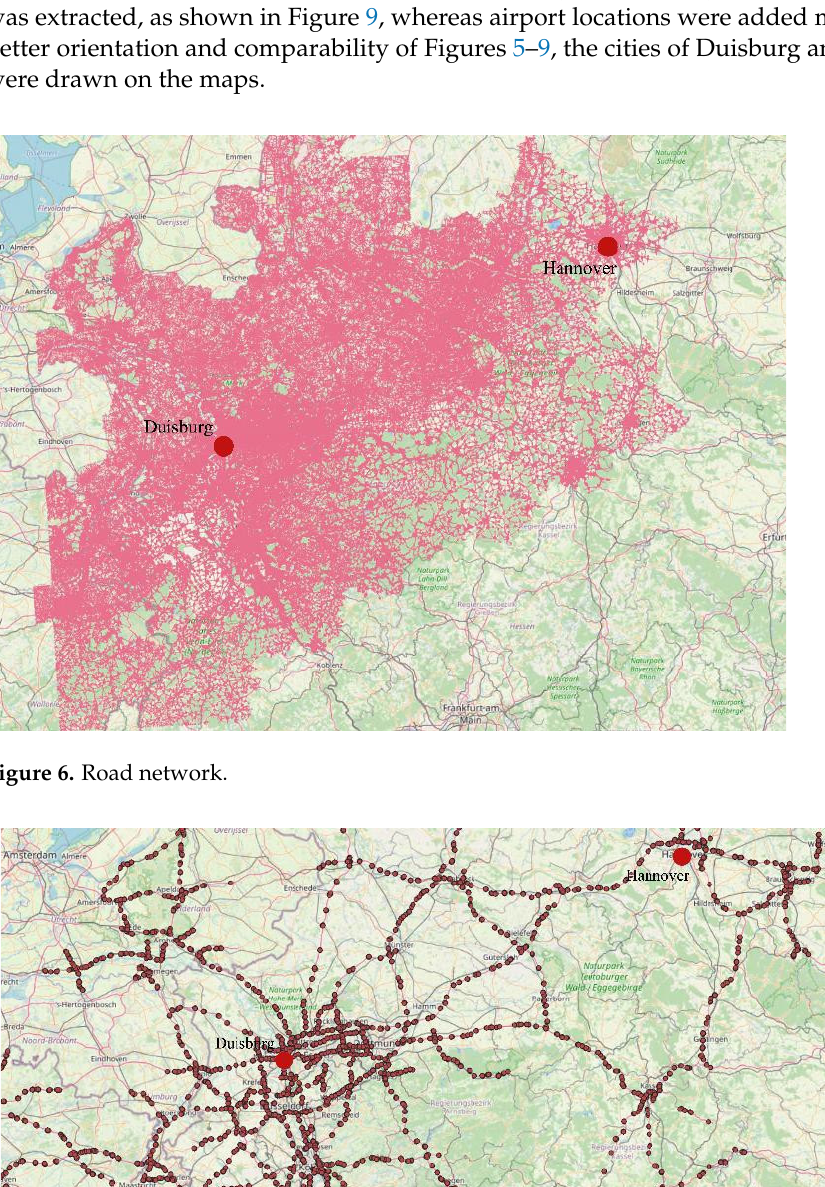
Figure 8. Locations of the rail infrastructure.